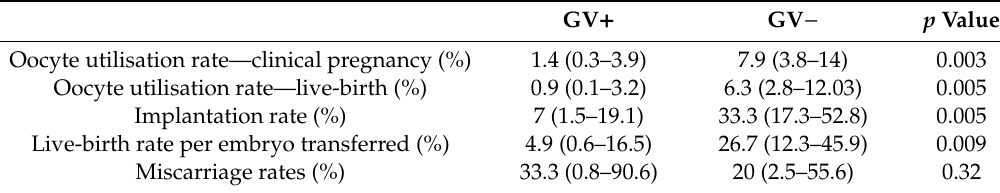
Table 5. Clinical outcomes—ICSI